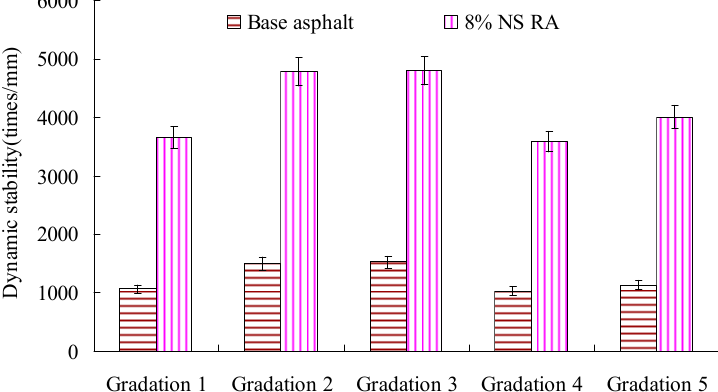
Figure 6. Dynamic stability of NS RA-modified asphalt mixtures with different gradations.